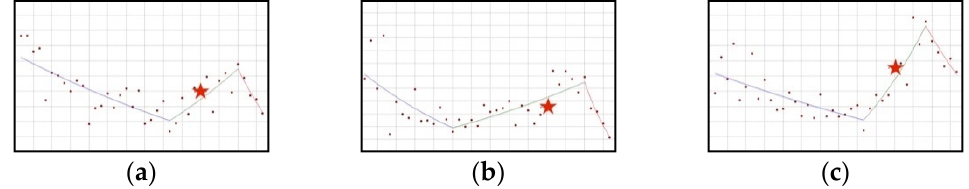
Figure 6. A schematic graph of the frequency of use of the ingredients in the respective quarters in the period from the first quarter of 2012 to the fourth quarter of 2021. The star denotes the moment of publication of a scientific opinion or a resolution concerning the ingredient. The height of placement of the symbol reflects the level of use of the ingredient. ( a ): Folic acid (Figure A30); ( b ): Manganese (Figure A31); ( c ): Zinc (Figure A32).